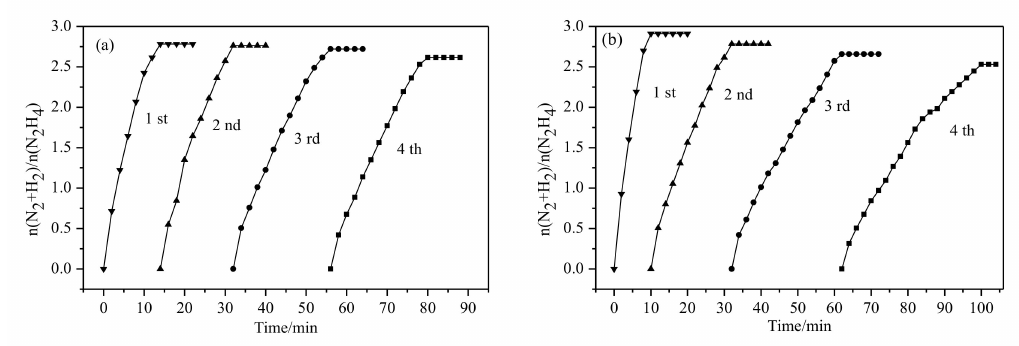
Figure 7. ( a ) Durability tests of Ni 9 Mo 1 (Pr 2 O 3 ) 0.375 on decomposition of hydrazine at 343 K and ( b ) durability tests of Ni 4 Mo@Cu 2 O on decomposition of hydrazine at 343